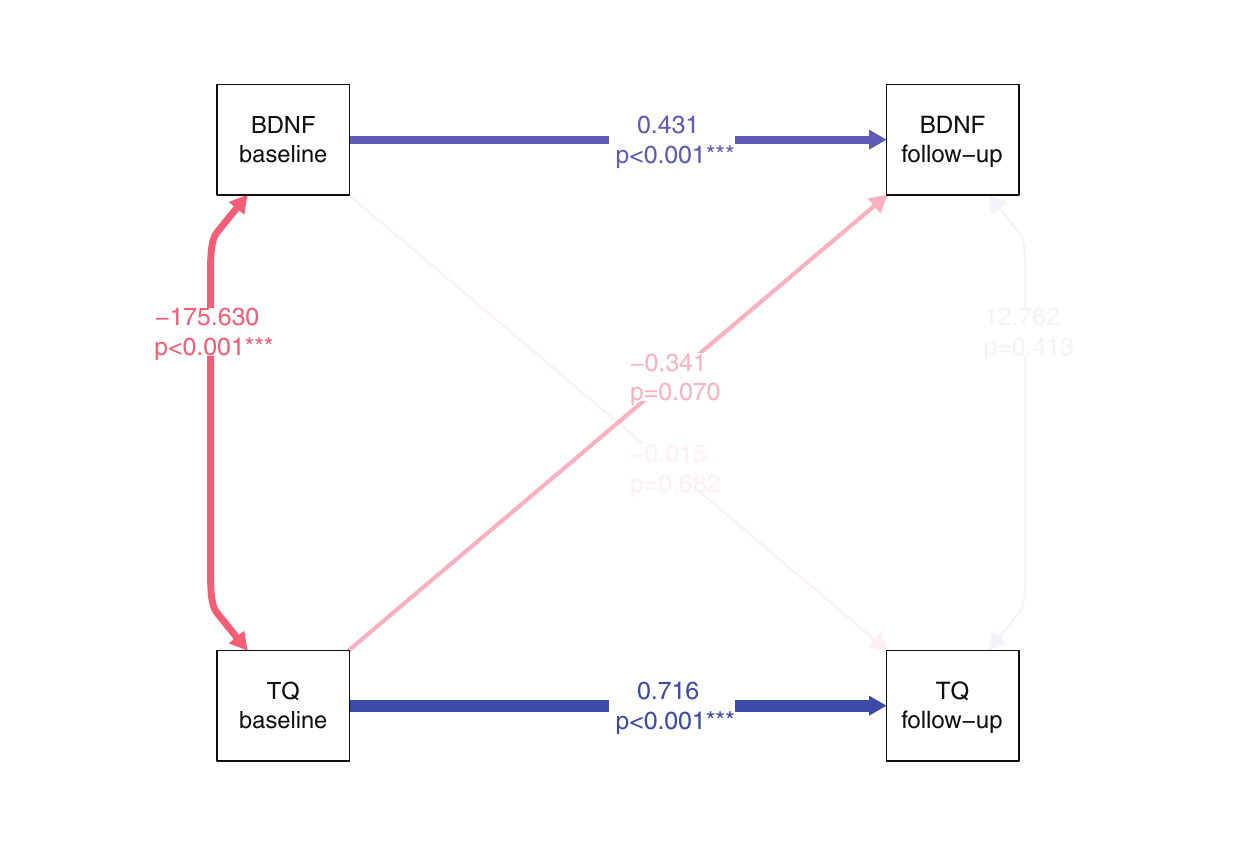
FIGURE 5 | Cross-lagged panel model (structural equation model) for the temporal relations between TQ scores and hair-BDNF values from baseline to follow-up. Blue lines indicate positive and red lines negative associations; line width indicates association strength. Numbers indicate standardized estimates and respective p -values. For the prediction of BDNF, mean hearing threshold and tinnitus loudness were included as control variables; for the prediction of TQ, concomitant SF-12 physical component summary scores and the dummy variable “marital status: separated / divorced / widowed” were included as control variables. To simplify the figure, control variables are not depicted. Model fit: N = 80, χ ² = 36.807, df = 12, p < 0.001; RMSEA = 0.144. BDNF, Brain-Derived Neurotrophic Factor; TQ, Tinnitus Questionnaire; SF-12, Short Form-12 Health